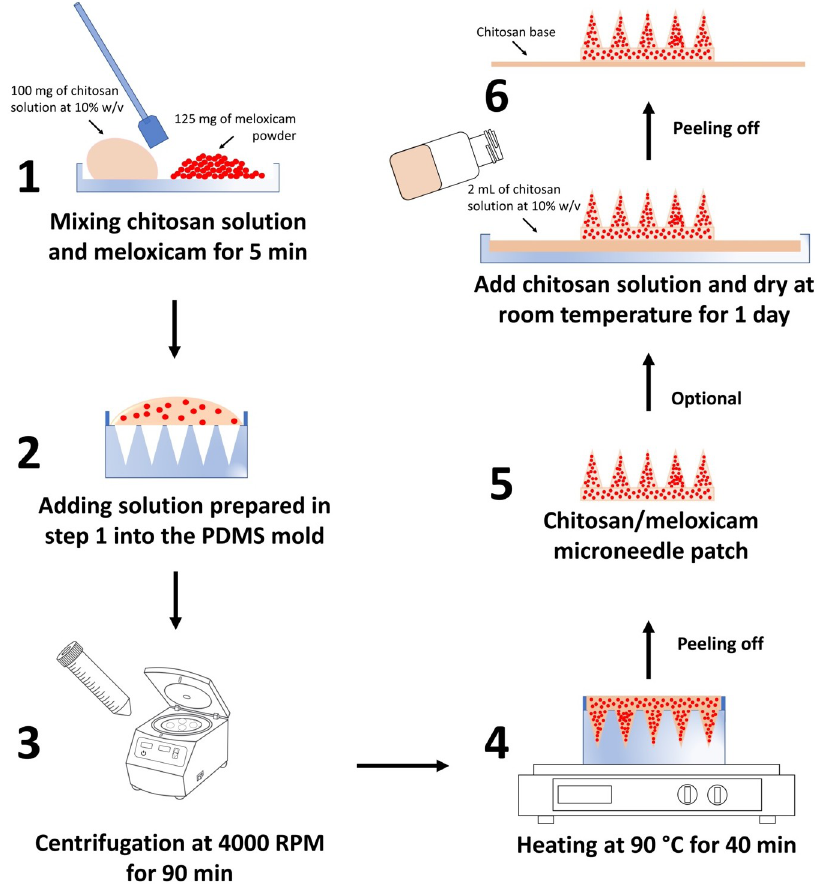
Fig 1. Schematic illustrations of the high concentrated chitosan/meloxicam microneedle patch fabrication process.